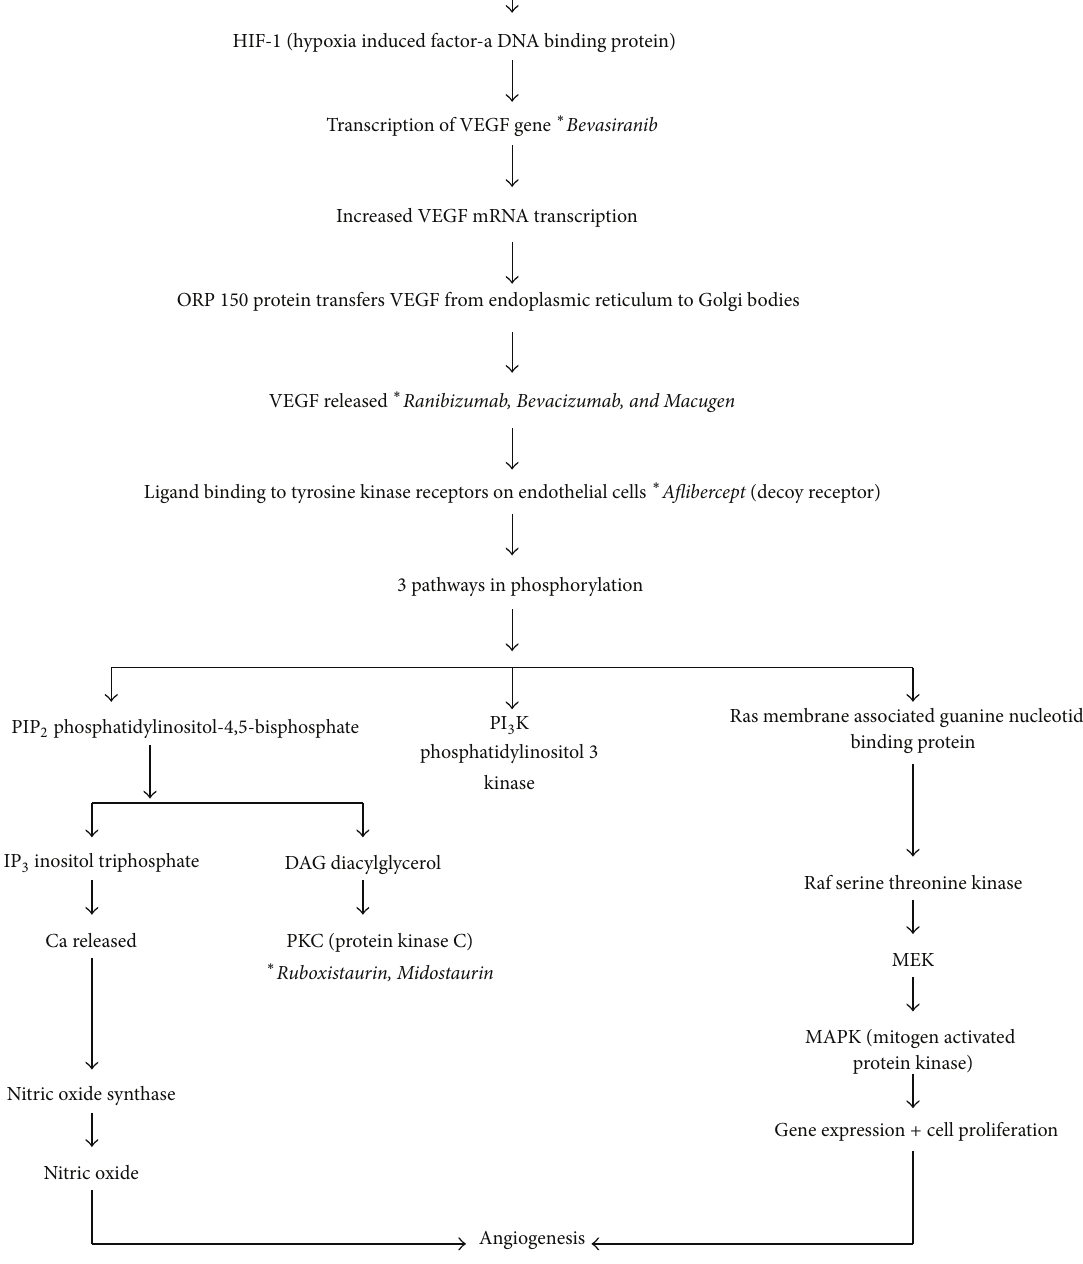
Figure 4: VEGF cascade in retinal hypoxia. Source: